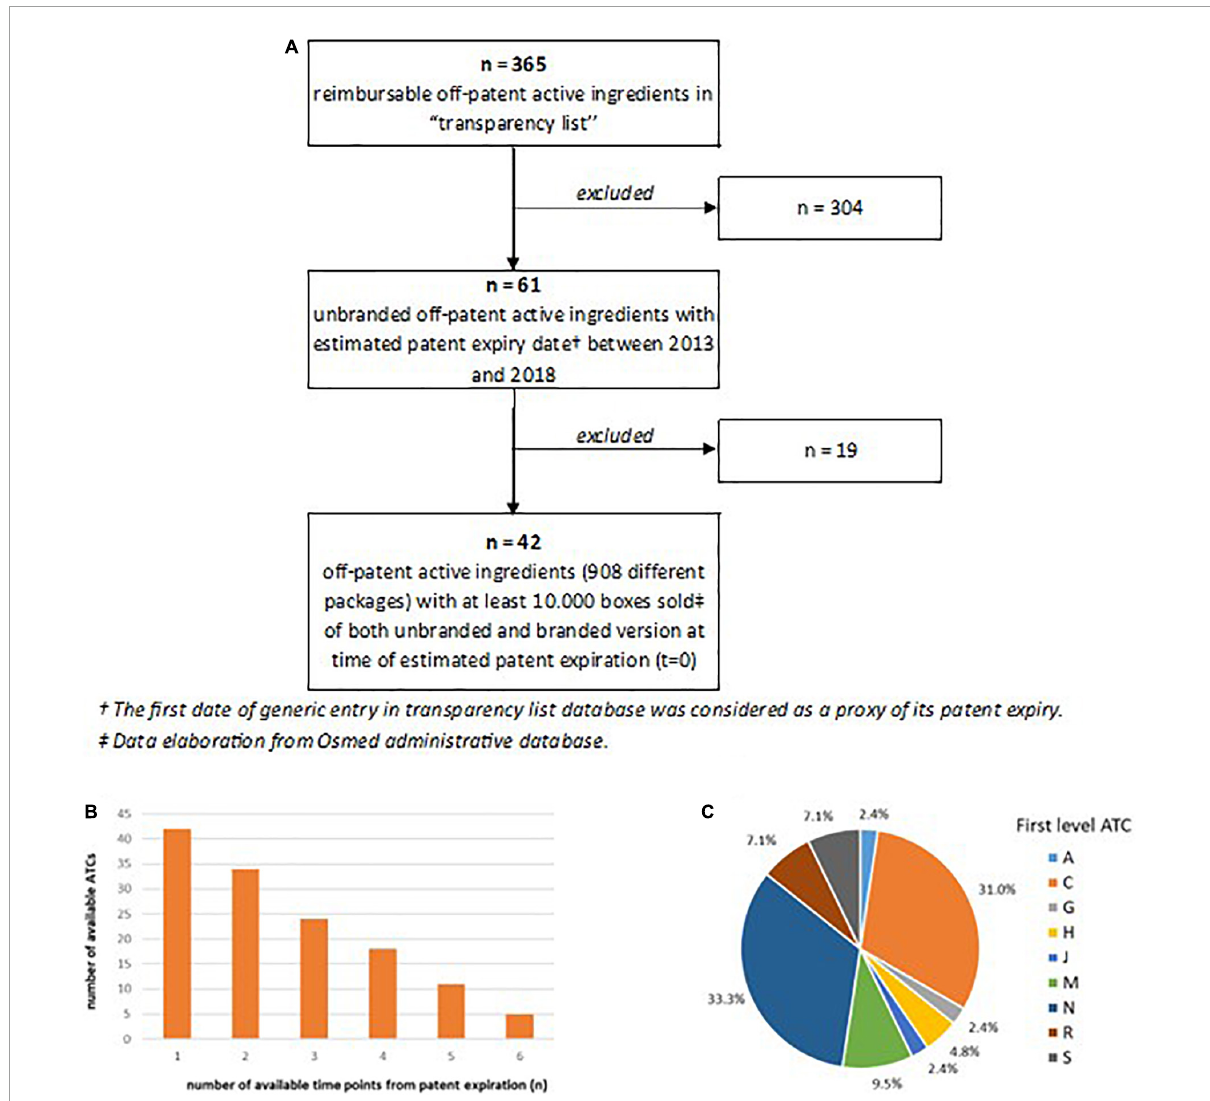
FIGURE1 (A) Flowchart of selection and inclusion of medicines in the analysis (5th level ATCs); (B) distribution of active ingredients by number of available time point from estimated patent expiration ( t = 0); (C) distribution of included active ingredients by first level